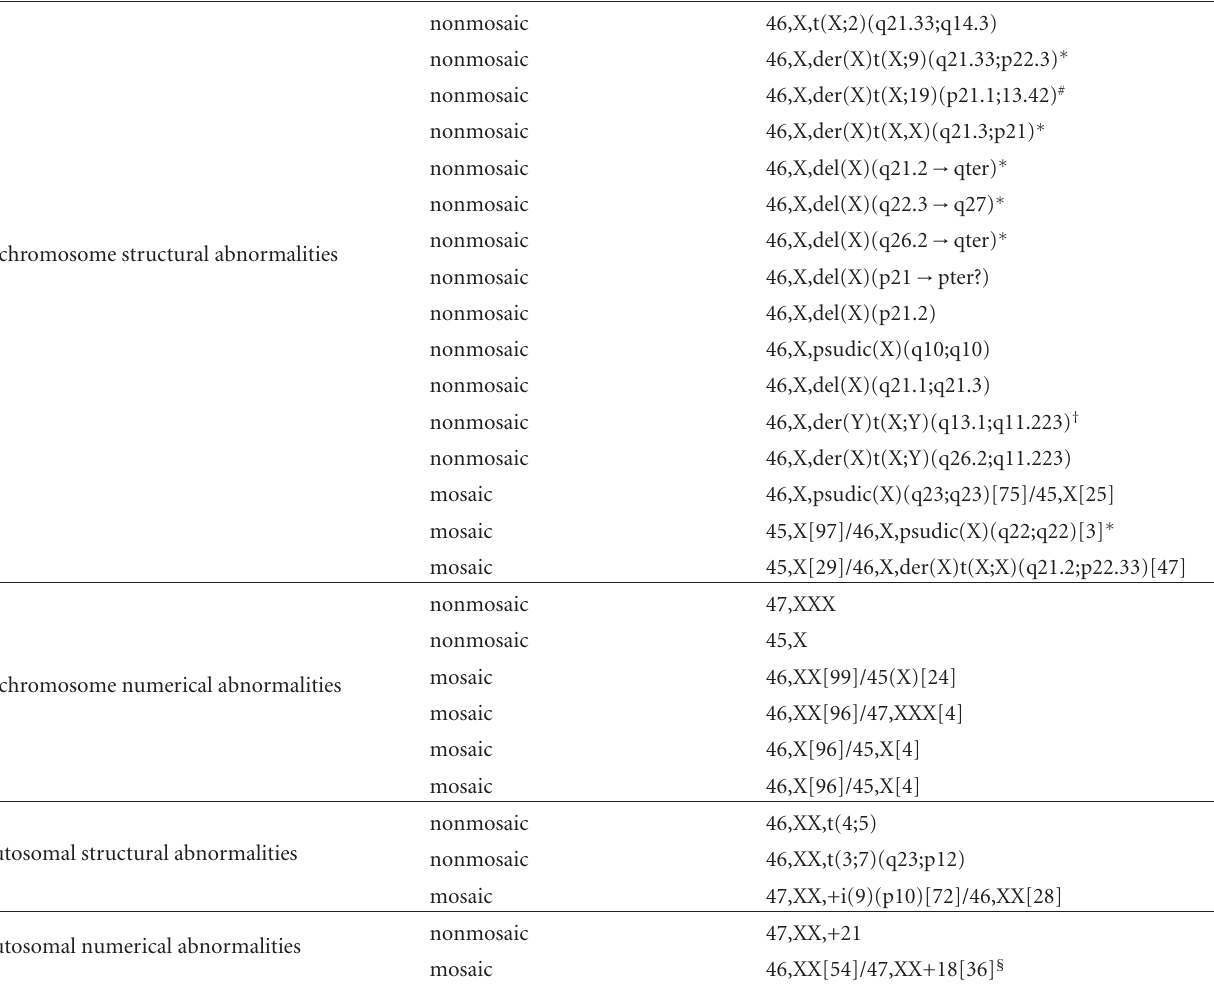
Table 1: Summary of the chromosomal abnormalities found in the POF patient